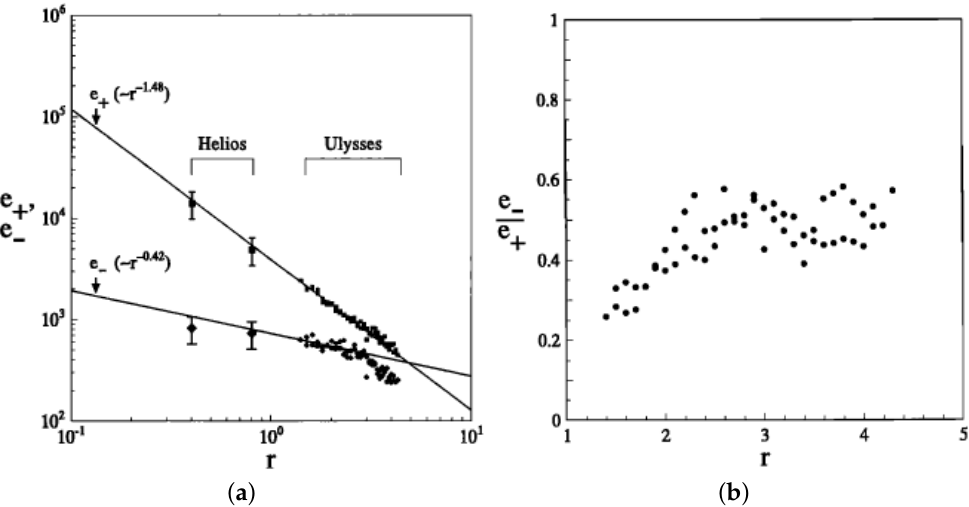
Figure 1. Reproduction of two figures (Figure 6, panel a and Figure 3, panel b) of the article by Bavassano et al. (2000) [12], where the evolution of the energies of the Elsässer modes separated e + and e − ( panel a ), reconstructed by merging data from different satellites (Helios 1 and 2 and Ulysses) and of the Alfvén ratio e − / e + ( panel b ), are shown. Courtesy of IOP. Permission to reprint #5320291212912.